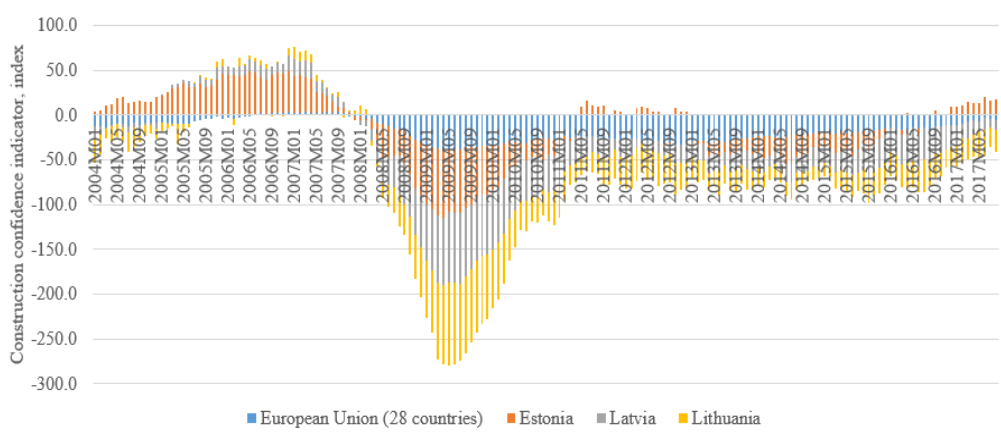
Fig. 2. Construction confidence indicators in the Baltic States, seasonally adjusted data, not calendar adjusted data. Data: Eurostat (n. d.). [Figure developed by